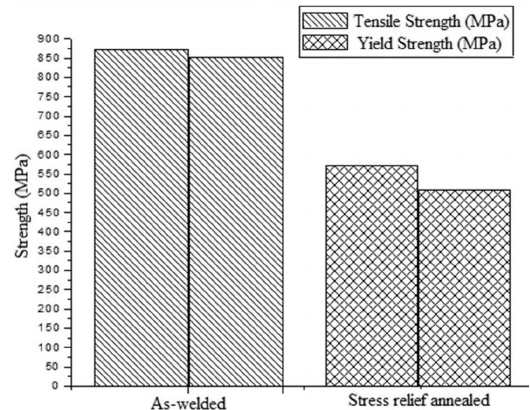
Figure 5. The tensile test result of friction welded dissimilar